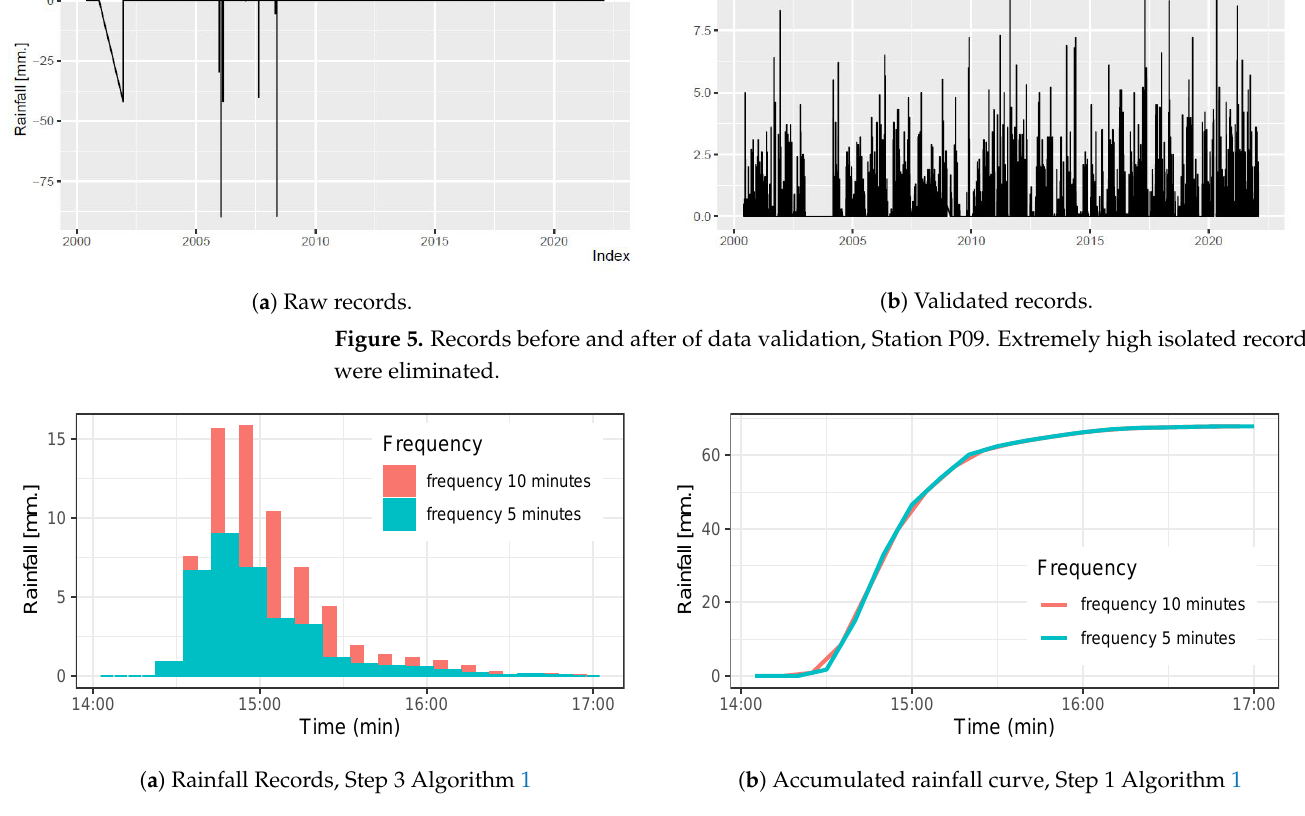
Figure 6. Example of frequency reduction from 10 to 5 min, in station Belisario SADMQ. Table 2. Captured events: station P09-Iñaquito